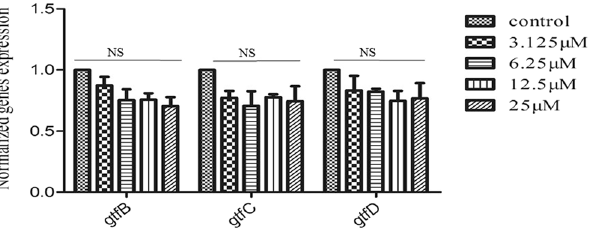
Figure 4. Effect of the compound #G43 on expression of gtfs in S. mutans. S. mutans UA159 cells treated with different concentrations of #G43 were harvested and used to prepare RNA. The expression of gtfs